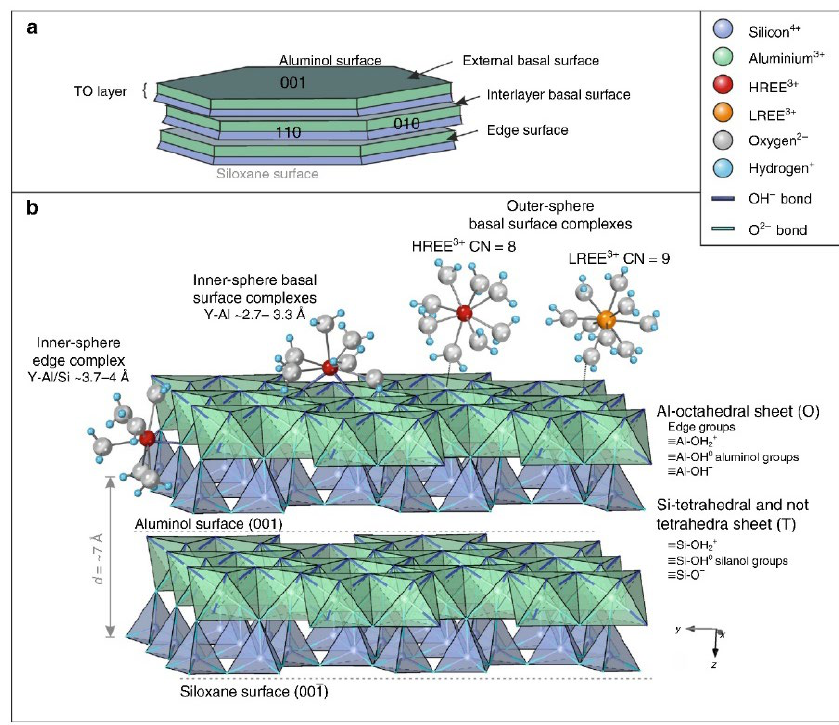
Figure 2. Occurrence characteristics of rare earth elements on the surface of kaolinite [41].